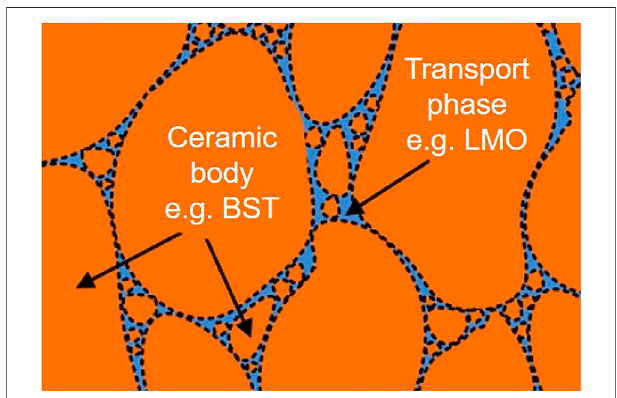
FIGURE 1 | Schematic microstructure of a BST-LMO upside-down composite densi fi ed at room temperature. Reproduced with permission (Nelo et al., 2019). Open access under the CC BY-NC-ND